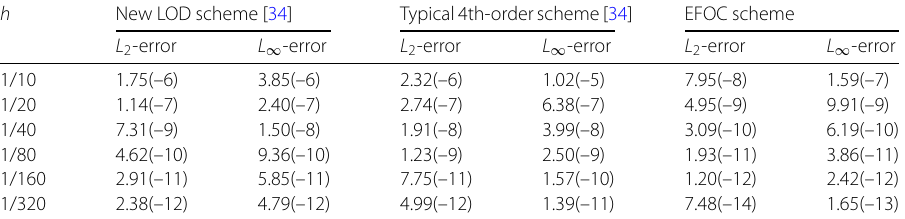
Table 4 The L ∞ and L 2 norm errors with τ = 0.0002 at t = 0.02 for different h for Problem 2 h New LOD scheme [34]